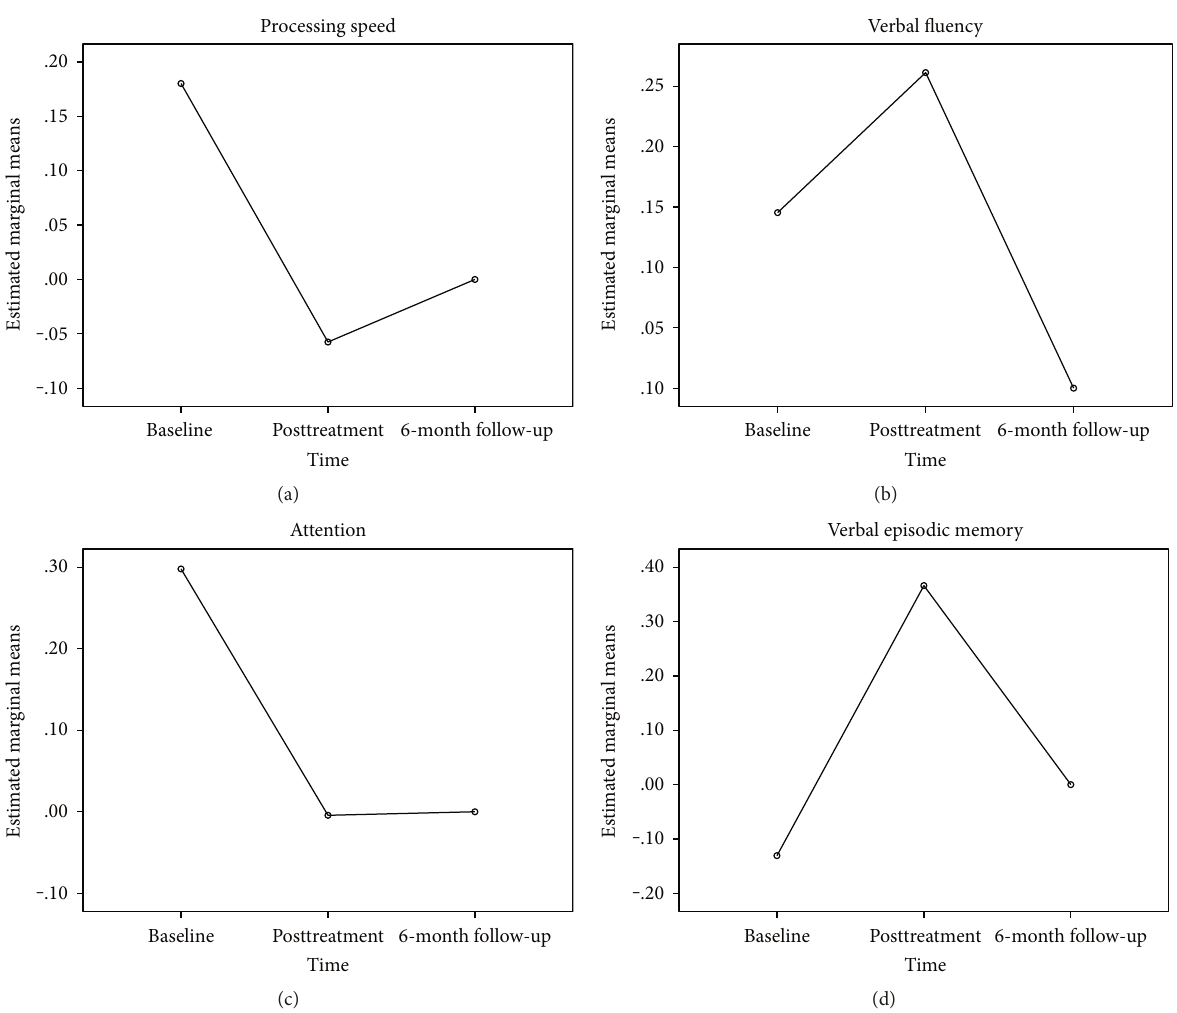
Figure 2: Composite cognitive domain performance ( z -scores) in the RehaCom group at baseline, posttreatment, and